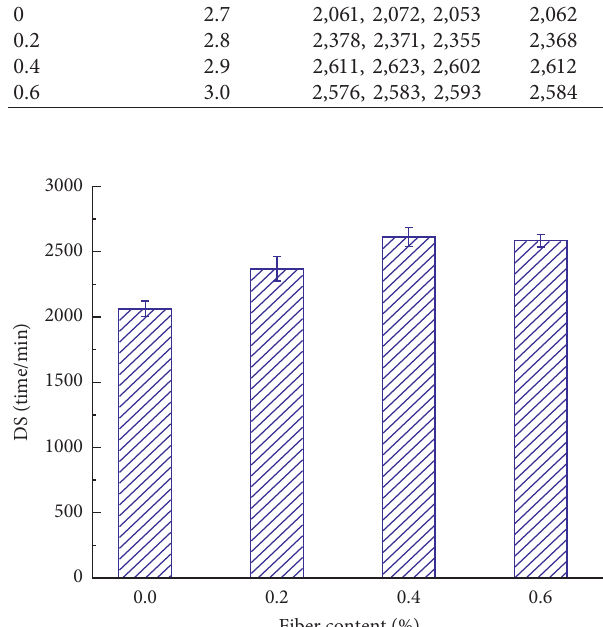
Figure 8: Work of fracture W f versus fiber content.